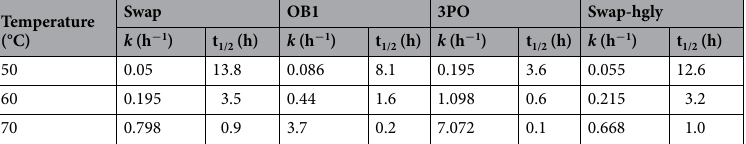
Table 3. Thermal inactivation constants and half-life values for purified domain-swap laccase and parent-types OB1 and 3PO. Values for hyperglycosylated isoform of domain-swap laccase (swap-hgly) are also provided for comparison.